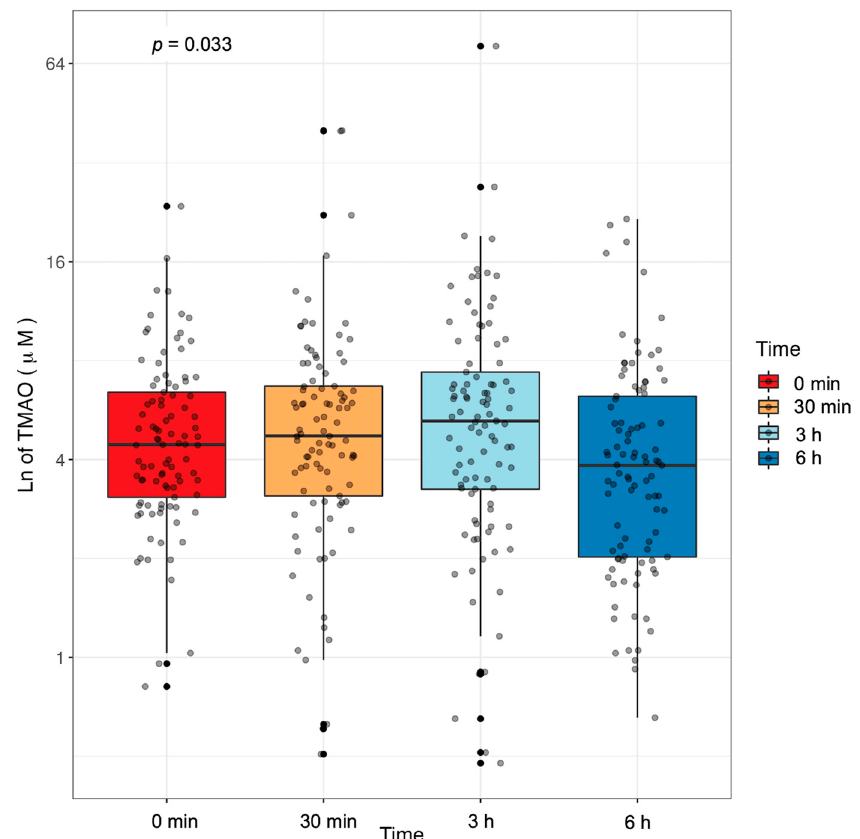
Figure 1. Plasma TMAO concentrations respond to an MMTT. Plasma TMAO concentrations in 97 adults change after consuming a mixed macronutrient tolerance test (MMTT) that contained minimal TMAO precursors. The p -value was calculated using ANOVA.